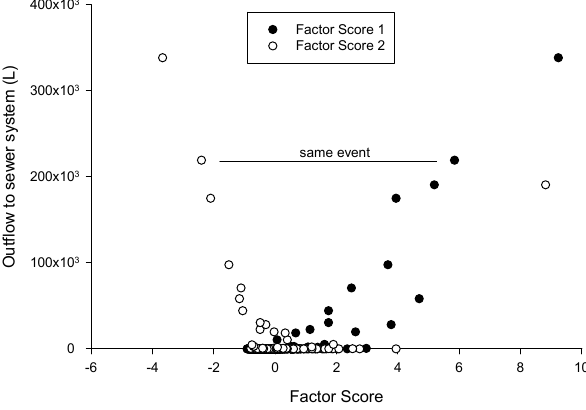
Figure 4. Storm event factor scores are plotted pairwise (black line illustrates the respective factor scores for same event) against flow volume.